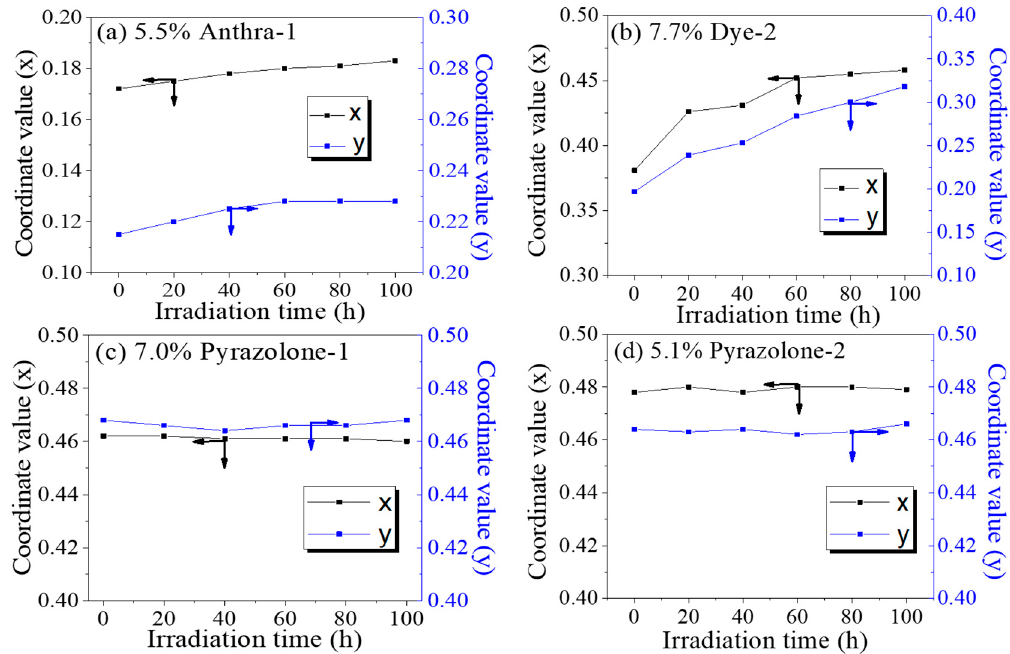
Figure 6. Variation of color coordinates (x, y) of oils in CIE1931 color space and ∆ E . (Irradiation condition: 0.55 W/m 2 (340 nm); Temperature 45 °C). ( a ) 5.5% Anthra-1, ( b ) 7.7% Dye-2, ( c ) 7.0% Pyrazolone-1, ( d ) 5.1% Pyrazolone-2. Table 1. Color change ( ∆ E ) of four formulated dyes after accelerated irradiation. Dye Before Irradiation After Irradiation Δ E L